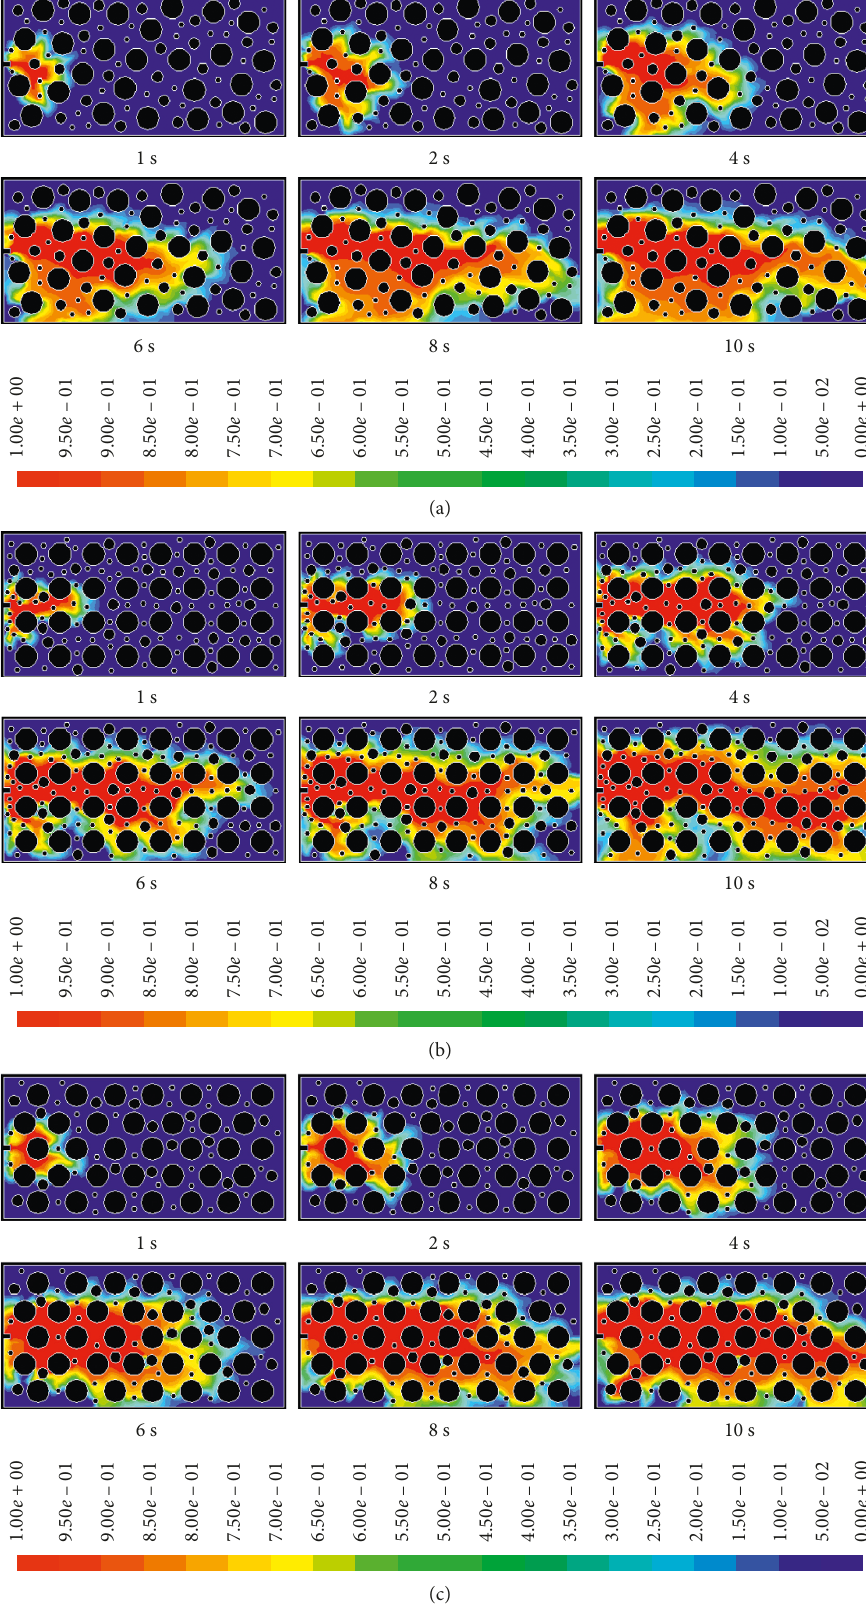
Figure 3: Migration process of water in different filling structures ( v � 1m/s and d � 100 μ m). (a) Structure 1. (b) Structure 2. (c) Structure